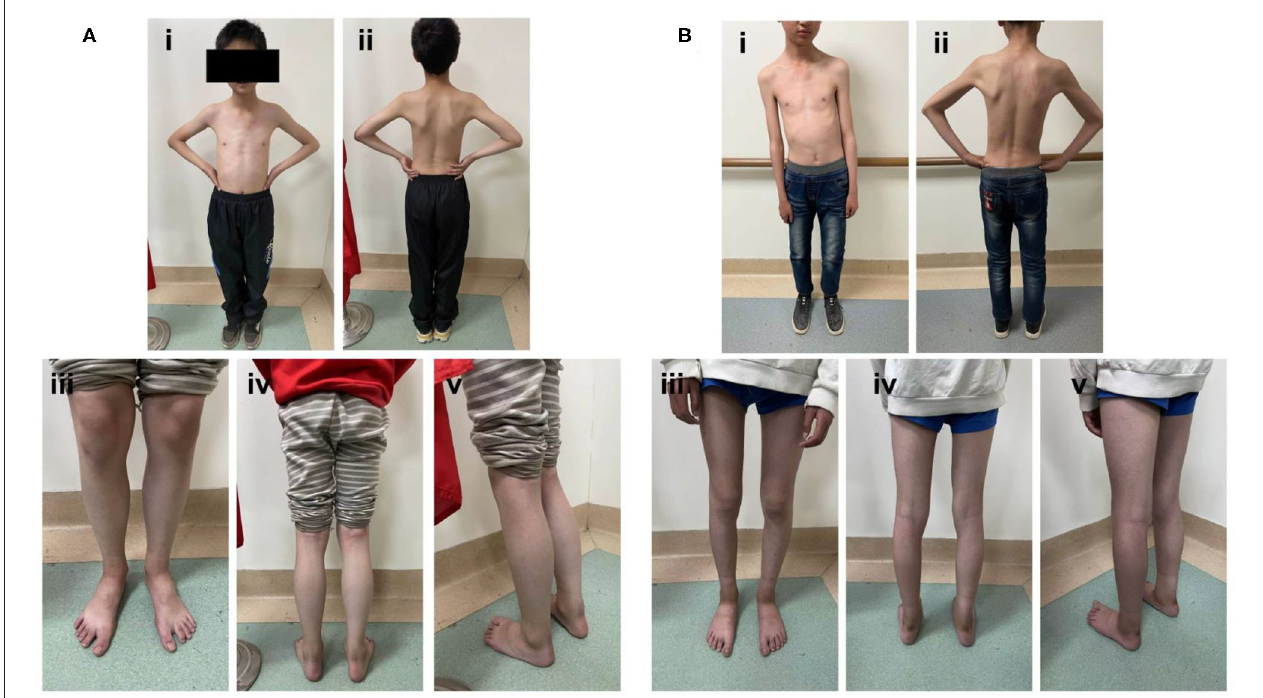
FIGURE 1 | Photographs of the proband at 10 years old. (A, B) The proband presented with obvious limb muscular atrophy and waddling gait. A neurological examination showed proximal muscle